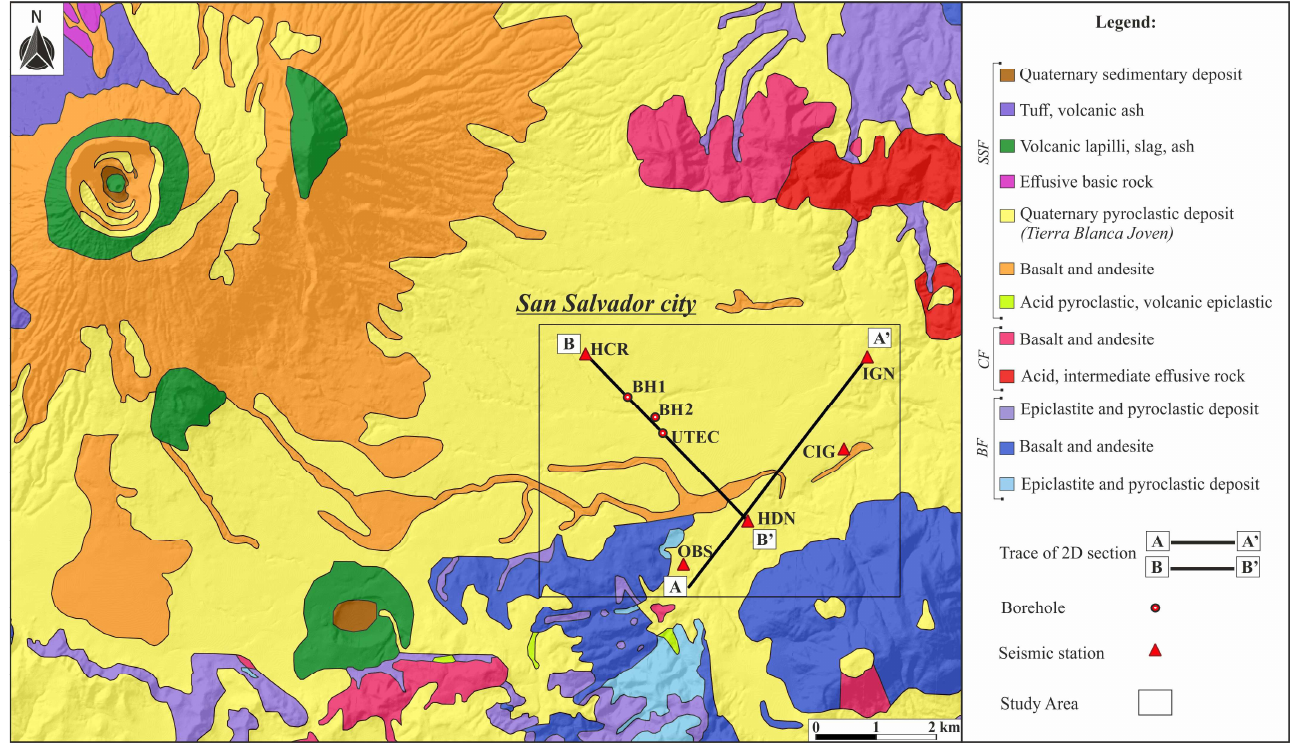
Figure 3. Geological map of the Metropolitan Area of San Salvador city (MASS). SSF— San Salvador Formation , CF— Cuscatlàn Formation , BF— Bálsamo Formation . The inset shows the trace of the 2D geo-lithological sections (after [54] modified).